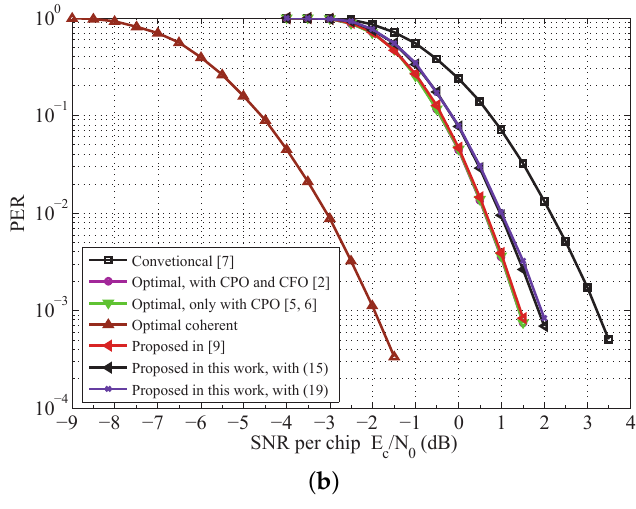
Figure 7. Performance comparison for various receivers. ( a ) BER performance of different receivers; ( b ) PER performance of different receivers.